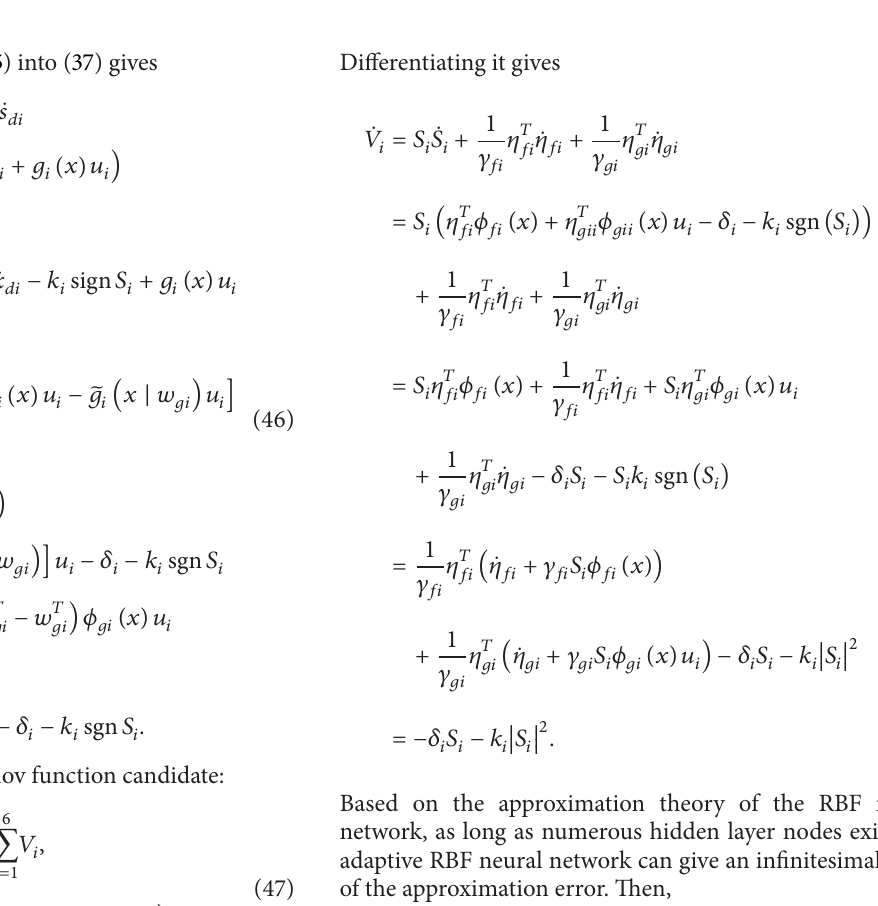
Figure 9: Six-wheel lunar rover climbing sloped terrain in RoSTDyn 3D